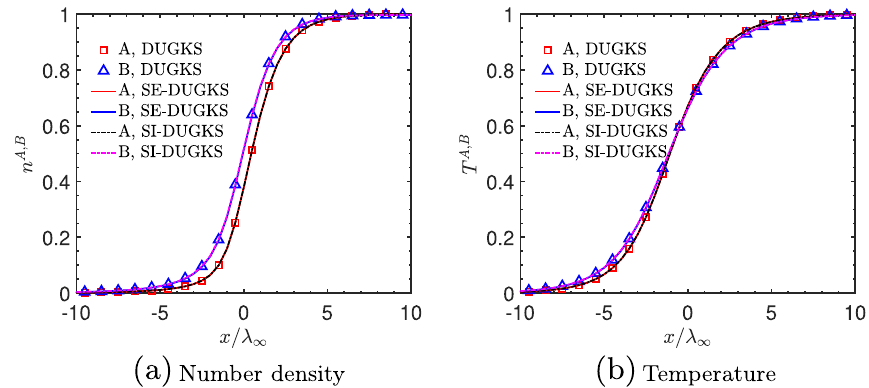
Fig. 7 Shock structure with Ma − = 3.0 , m B ∕ m A = 0.5 , and 𝜒 A = 0.9